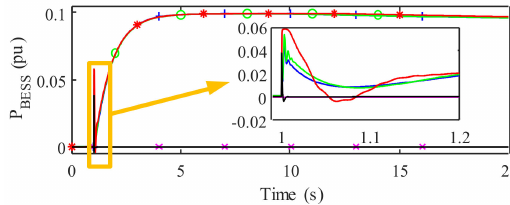
Figure 11. BESS active power variation on load change for VOC (black, solid line), VSM (red, * marked), VI (green, circle marked), and droop (blue, + marked) control systems, as well as no VSC connection (magenta, × marked).